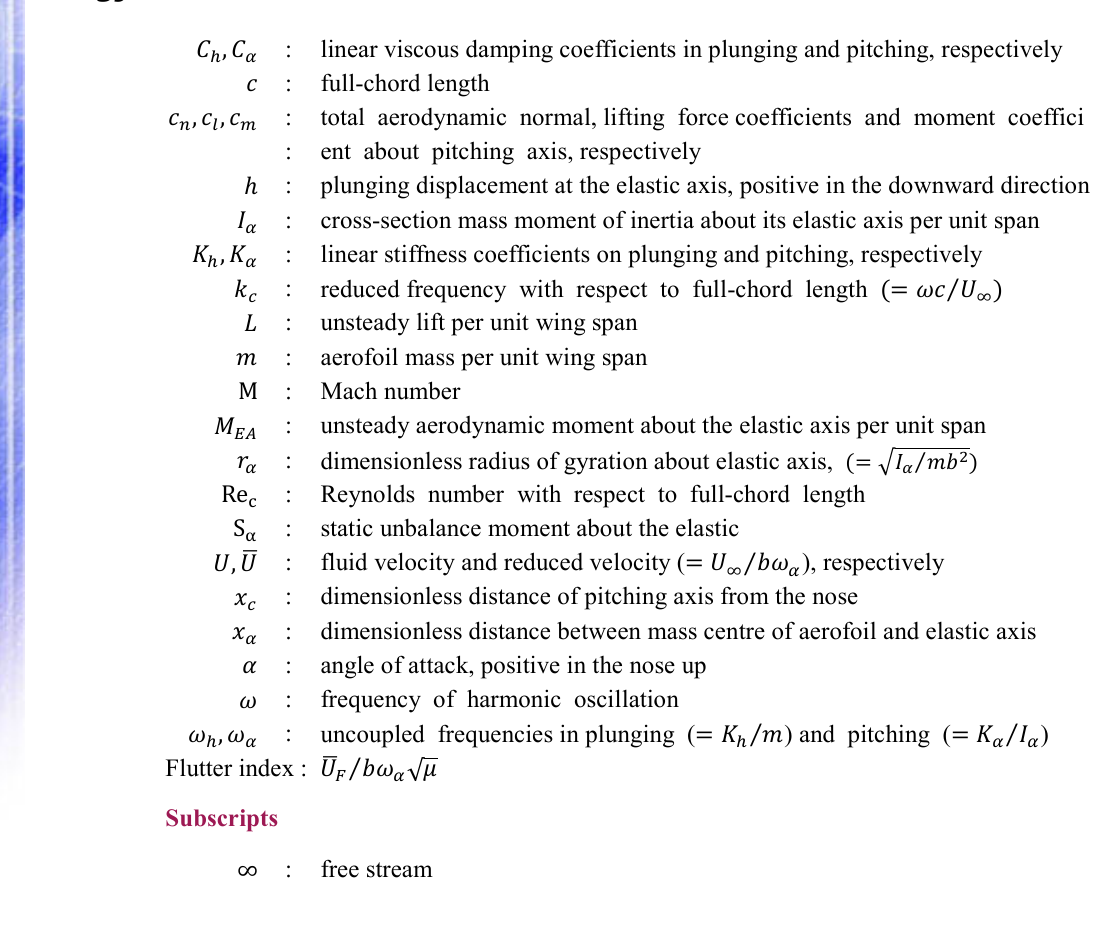
ent about pitching axis, respectively